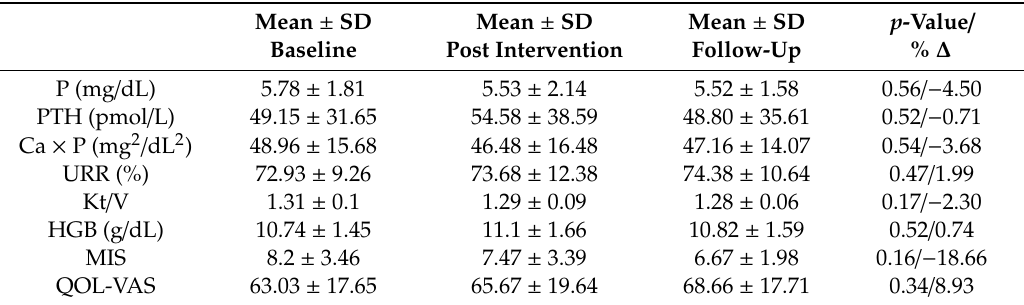
Table 2. Study outcomes of all patients ( n =